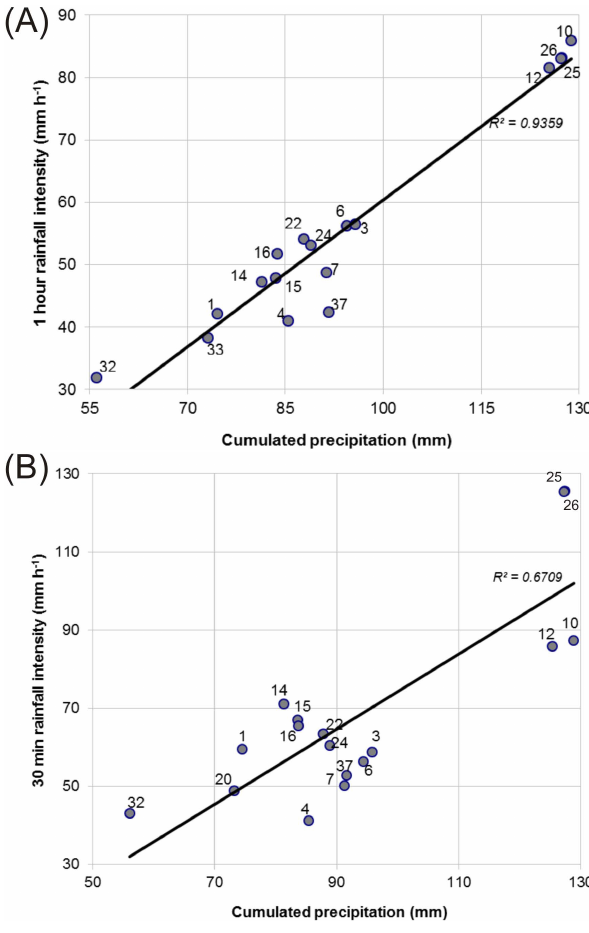
Fig. 9. Relationship between the event-cumulated rainfall depth and the 1-h peak (a) and 30-min peak (b) rainfall intensity for the 17 IPEC